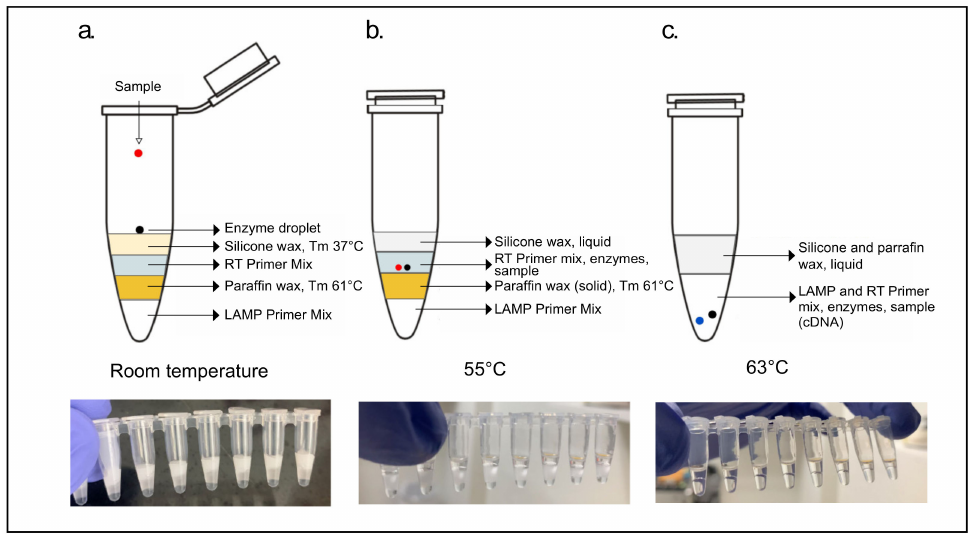
Figure 3. Two-step reaction-ready cartridge layering. Cartridge layers at ( a ) room temperature, ( b ) 55 ◦ C and ( c ) at 63 ◦